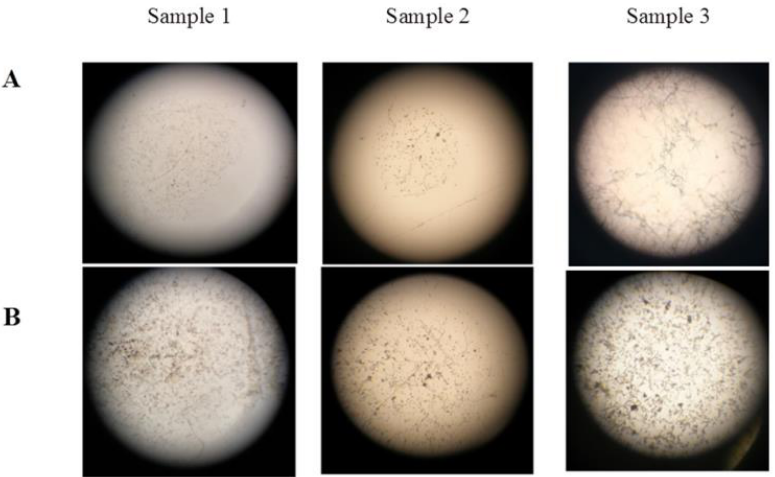
Figure 4. Microscopy of fouling area on polysiloxane coatings, treated according to option 1. Magnification 64 × ( A ); 160 × ( B ).